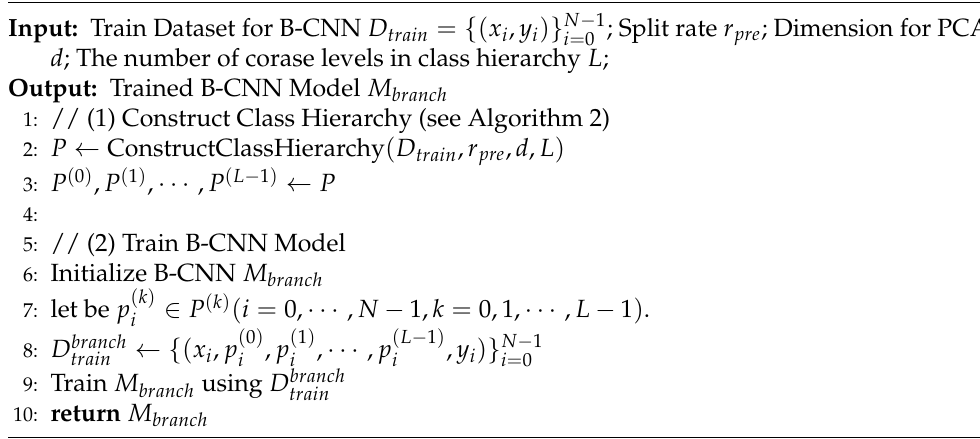
Algorithm 1 Class hierarchy-adaptive